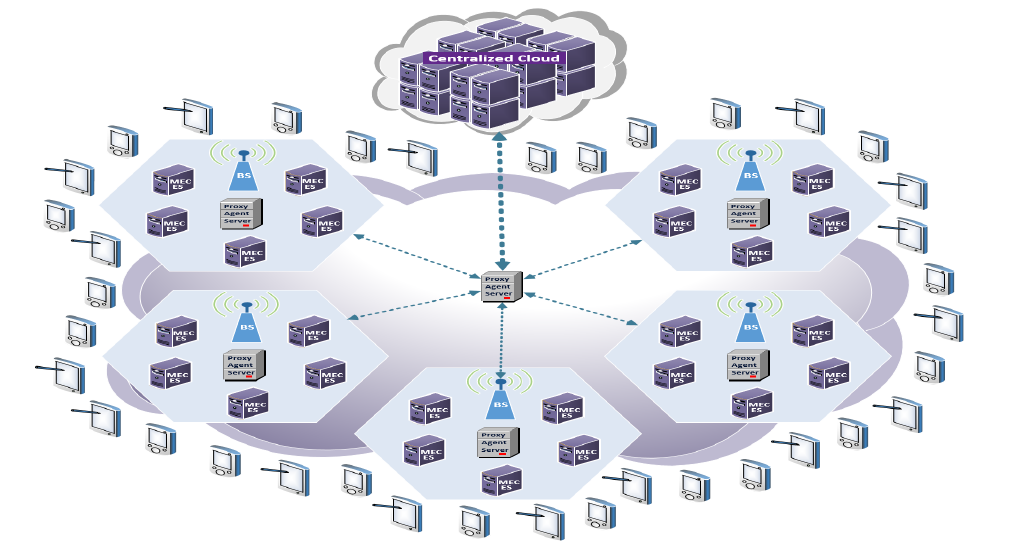
Figure 2. The proposed system model for the CMUMS Caching